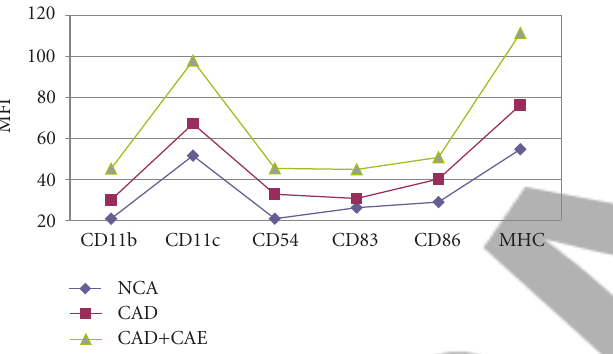
Figure 1: The graphic showing the mean expression levels of the activation markers on monocyte-derived dendritic cells in each study group. NCA: the group with normal coronary arteries. CAD: the group with coronary artery disease. CAD + : the group with coronary artery disease and coronary artery ectasia. MFI: mean fluorescence